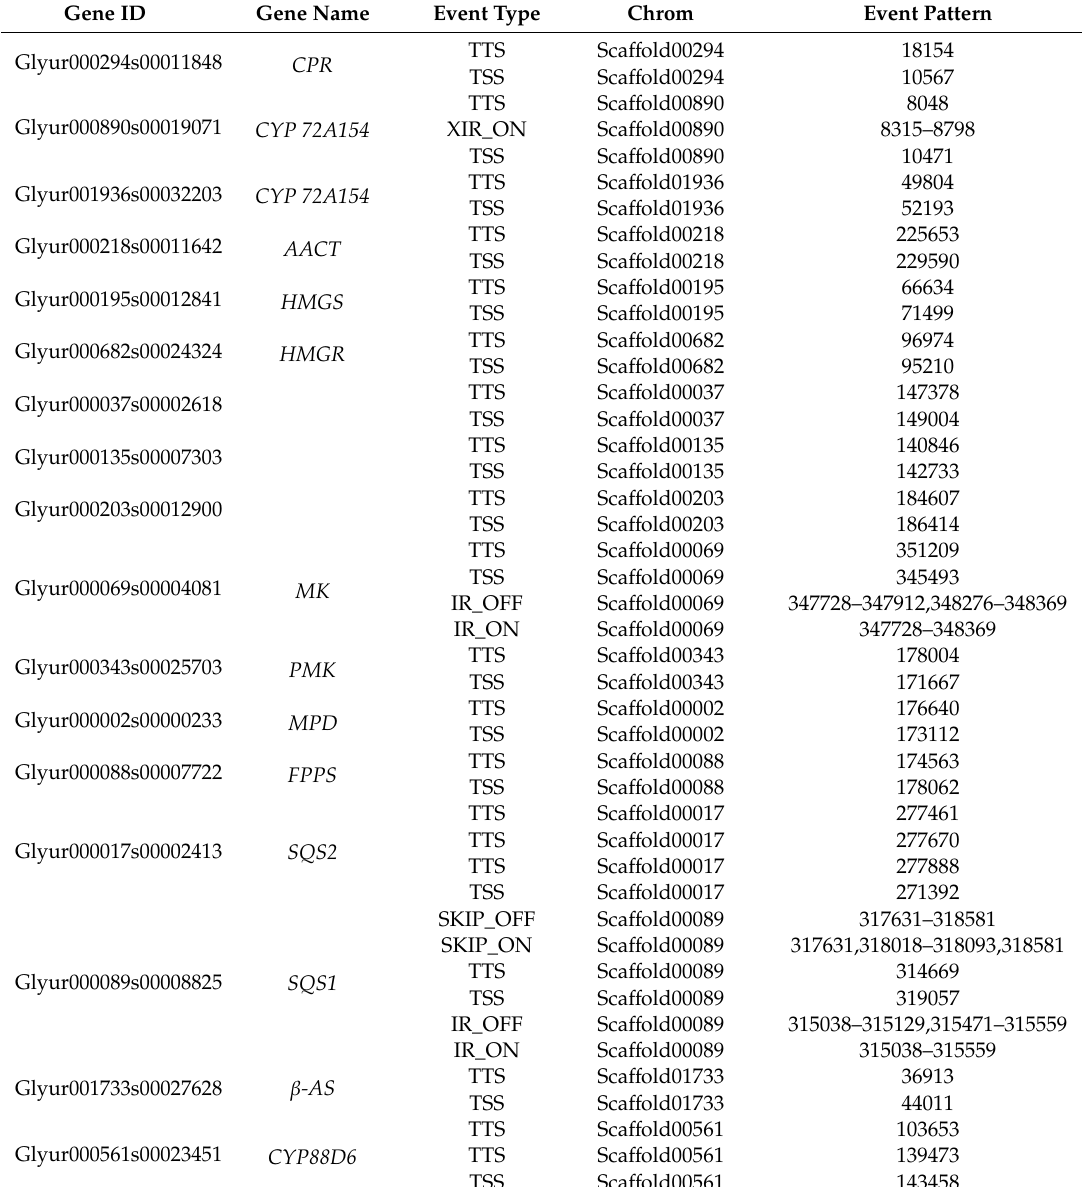
Table 3. AS occurred in structural genes of